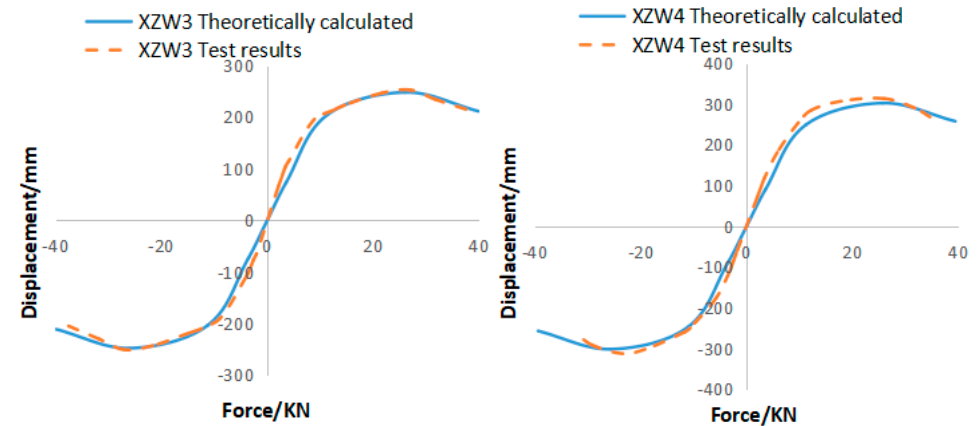
Figure 11. Comparison between theoretical and experimental skeleton curves.